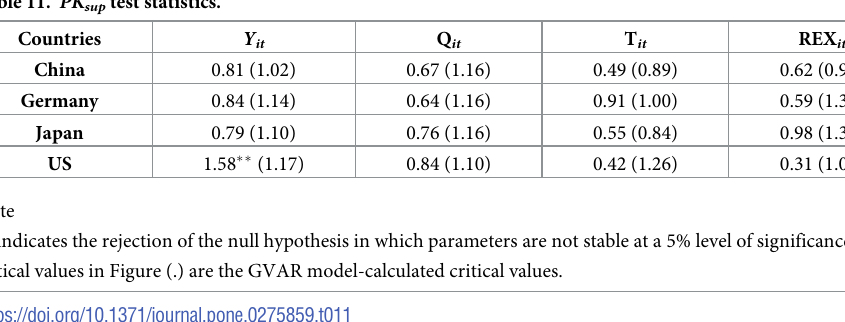
Table 11. PK sup test statistics.